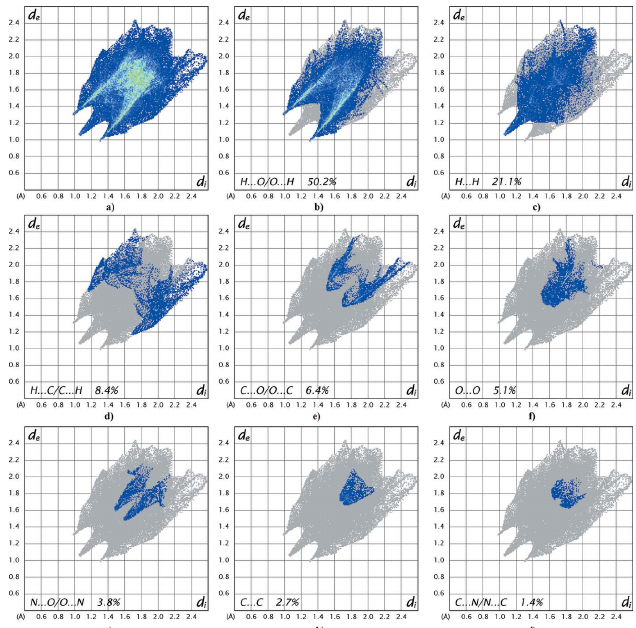
Figure 4 Full two-dimensional fingerprint plots for the title compound, showing ( a ) all interactions, and delineated into ( b ) H (cid:2)(cid:2)(cid:2) O/O (cid:2)(cid:2)(cid:2) H, ( c ) H (cid:2)(cid:2)(cid:2) H, ( d ) H (cid:2)(cid:2)(cid:2) C/C (cid:2)(cid:2)(cid:2) H, ( e ) C (cid:2)(cid:2)(cid:2) O/O (cid:2)(cid:2)(cid:2) C, ( f ) O (cid:2)(cid:2)(cid:2) O, ( g ) N (cid:2)(cid:2)(cid:2) O/O (cid:2)(cid:2)(cid:2) N, ( h ) C (cid:2)(cid:2)(cid:2) C and ( i ) C (cid:2)(cid:2)(cid:2) N/N (cid:2)(cid:2)(cid:2) C interactions. The d i and d e values are the closest internal and external distances (in A˚ ) from a given point on the Hirshfeld surface. Relative contributions are